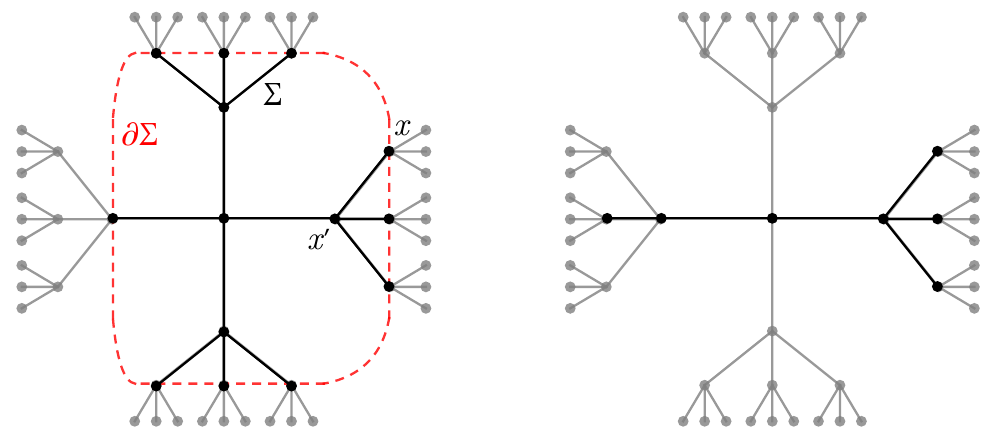
Figure 4 . Left: a fat subgraph (cid:6) of a regular tree. The dashed line passes through the points on the boundary @ (cid:6) of (cid:6). Any point x on the boundary has a unique neighbor x 0 in the interior of (cid:6). Right: a subgraph of the same regular tree which is not